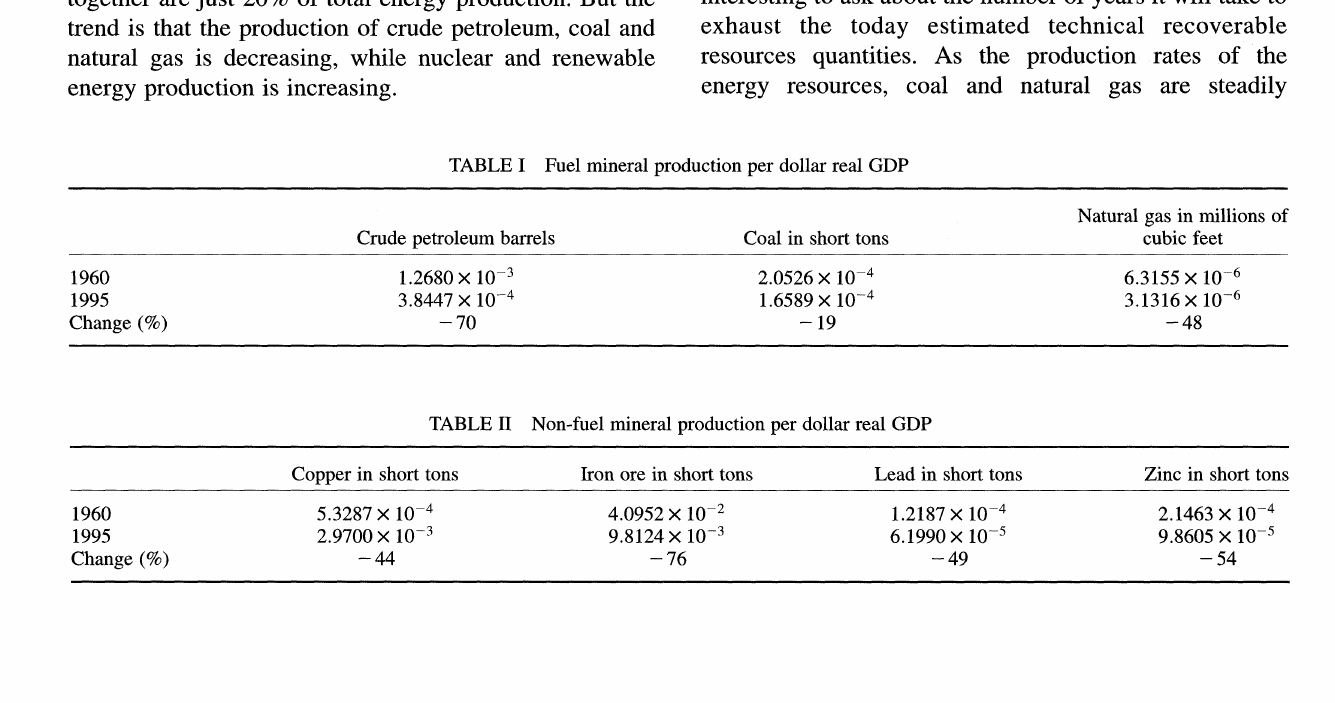
FIGURE 2 Fuel: mineral production per 1990 $ GDP (coal production measured short tons, crude petroleum production measured in barrels, natural gas production measured in millions of cubic feet).